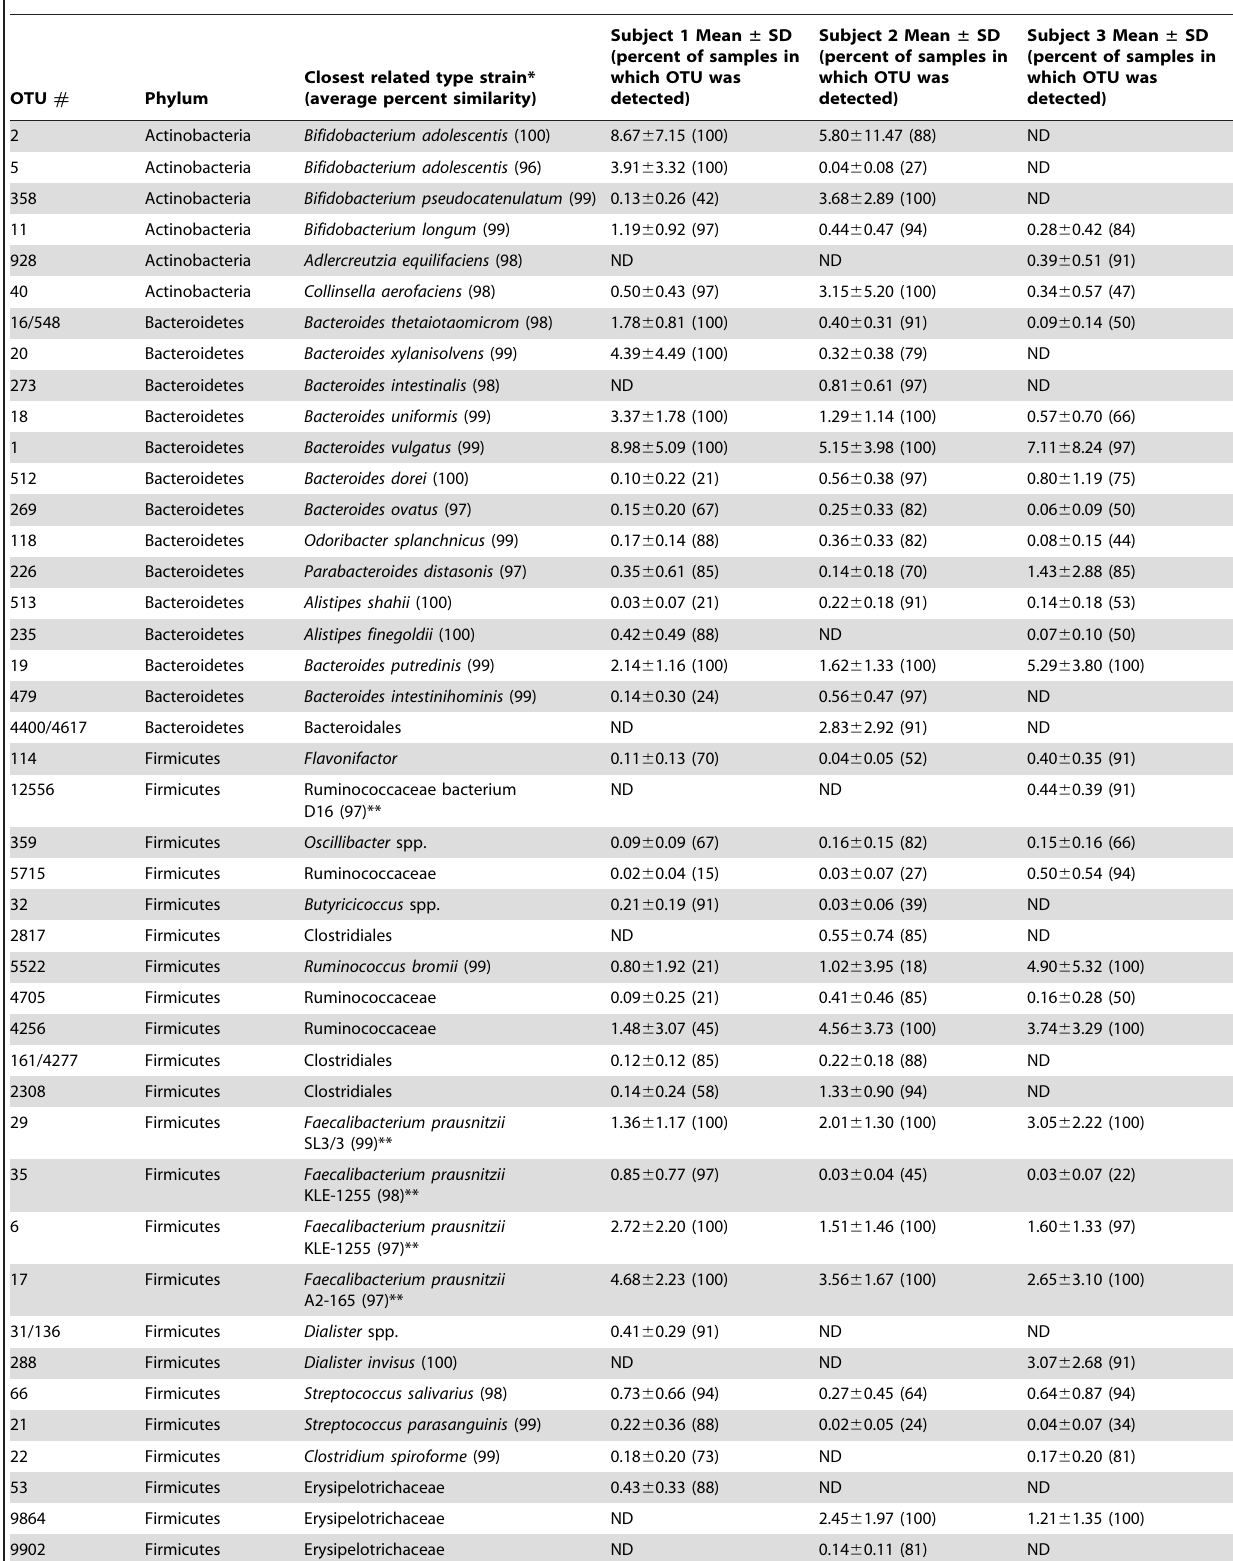
Table 1. Abundance (%) of bacterial OTUs that comprise the temporal core within the fecal microbiota of three humans over a one-year